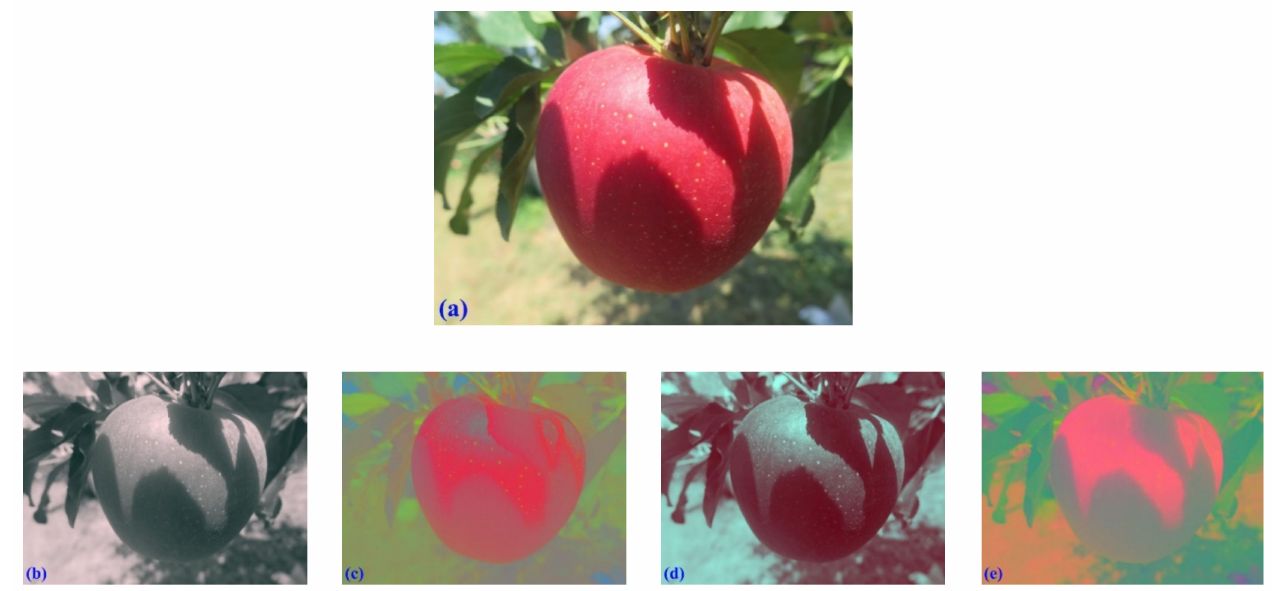
Figure 5. Apple image obtained by parallel and vertical decomposition along the COIs. ( a ) Origin image, ( b ) The result of the parallel decomposition of the image along the shadow COI, ( c ) The result of the vertical decomposition of the image along the shadow COI, ( d ) The result of the parallel decomposition of the image along the halation COI, ( e ) The result of the vertical decomposition of the image along the halation